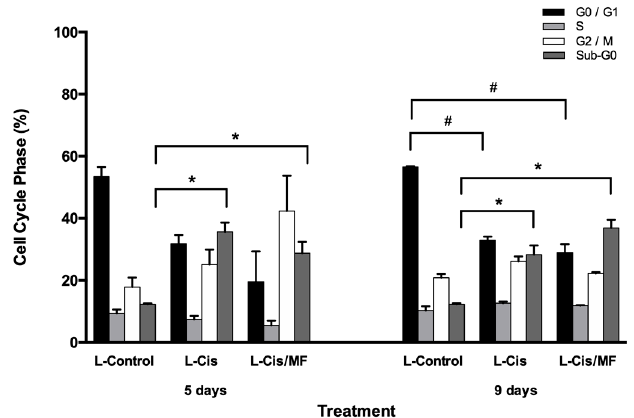
Figure 4. Analysis of the cell cycle for HeLa cells at days 5 and 9 post-treatment in vitro. L-Control (blank liposomes); cisplatin-loaded liposomes (L-Cis) and cisplatin / mifepristone-loaded liposomes (L-Cis / MF). Data are expressed as the mean ± SD of three independent experiments. * and # Significant difference ( p < 0.05) between L-Control and L-Cis or L-Cis/MF.